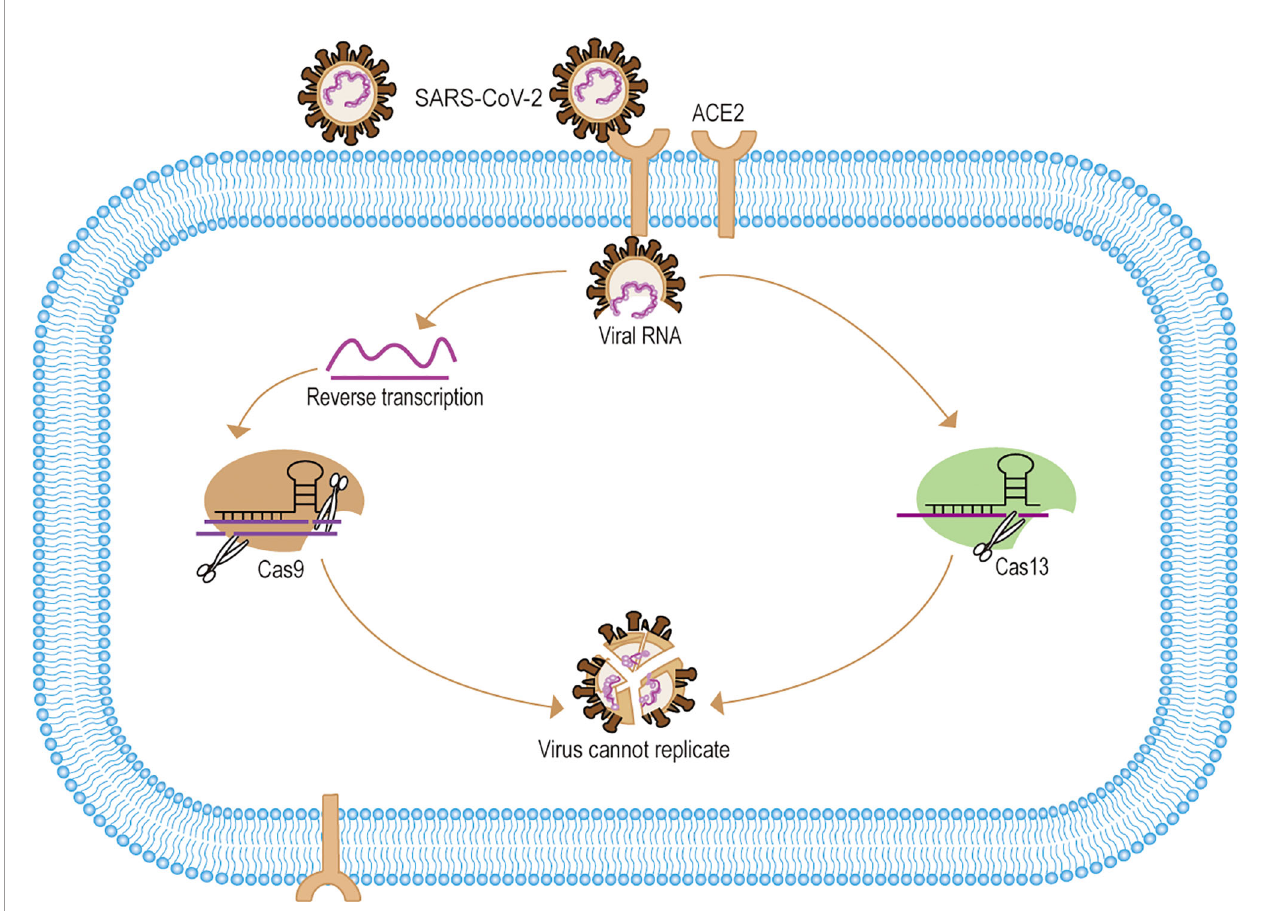
FIGURE 2 | Mechanisms of CRISPR/Cas systematic elimination of SARS-CoV-2. (1) SARS-CoV-2 targets the ACE2 receptor to release viral RNA into cells. (2) After reverse transcription of the viral RNA to form dsDNA, the pre-designed sgRNA-Cas9 identi fi ed and speci fi cally cleaved the viral DNA. (3) For Cas13 the system can directly identify and eliminate viral RNA. (4) The CRISPR/Cas system eliminates the SARS-CoV-2 gene, thus making the viral RNA unable to replicate and the viral gene unable to be expressed, and eventually making SARS-CoV-2 unable to